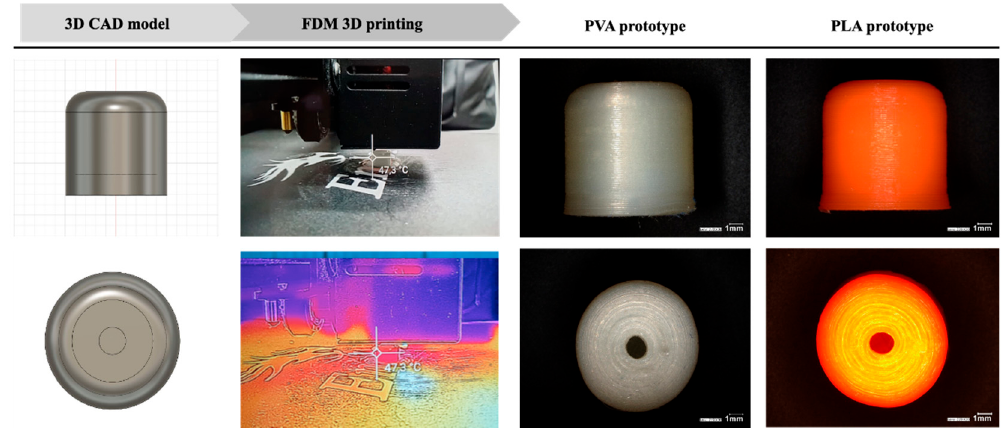
Figure 1. Printlet preparation process and digital microscopic images of polyvinyl alcohol (PVA-) and polylactic acid (PLA)-based prototype with one orifice.